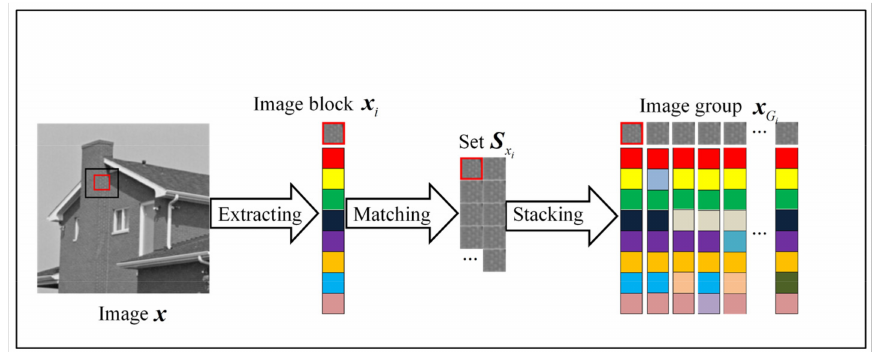
Figure 1. The flow chart of image group construction, where Extracting means extracting sample image blocks, Matching means matching similar image blocks, and Stacking means transforming similar image blocks to get image